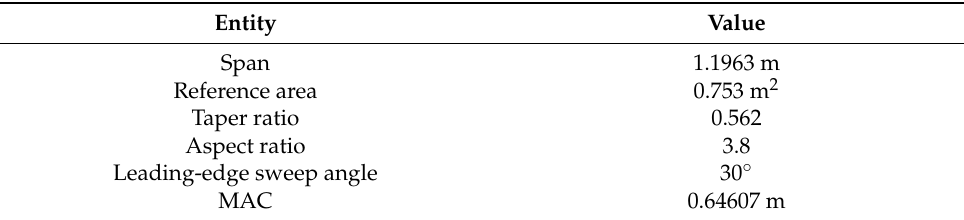
Figure A1. ONERA M6 wing geometry. Table A1. ONERA M6 wing geometric data.